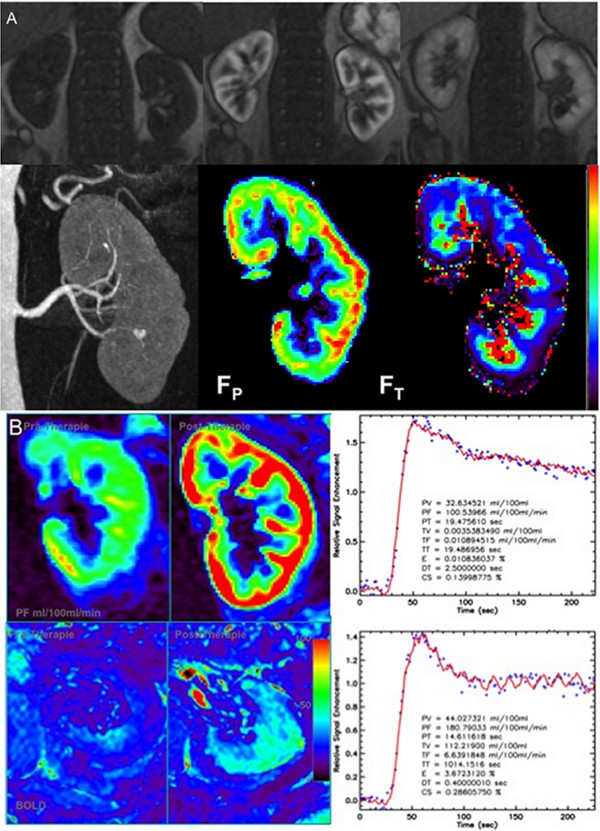
Using dedicated post-processing, renal perfusion and filtration can be quantified based on high temporal resolution data sets. Figure 6A illustrates in this instance non-enhanced, arterial phase and late venous phase images, subsequently acquired with a high-temporal resolution TurboFLASH sequence. After post-processing, color coded maps as well as quantified values of renal perfusion (plasma flow, FP) and filtration values (tubular flow, FT) can be derived from the primary MR data set. This analysis is, for example, especially helpful in evaluating therapeutic success after interventional procedures as shown in Figure 6B. After stenting of a high-grade renal artery stenosis, the plasma flow value normalized as did cortical and medullary oxygenation, both of which can be measured using a BOLD-sequence. These techniques along with BOLD, as illustrated in this case, have extended the utility of MR beyond purely morphologic assessments, allowing detection of functional renal impairments.